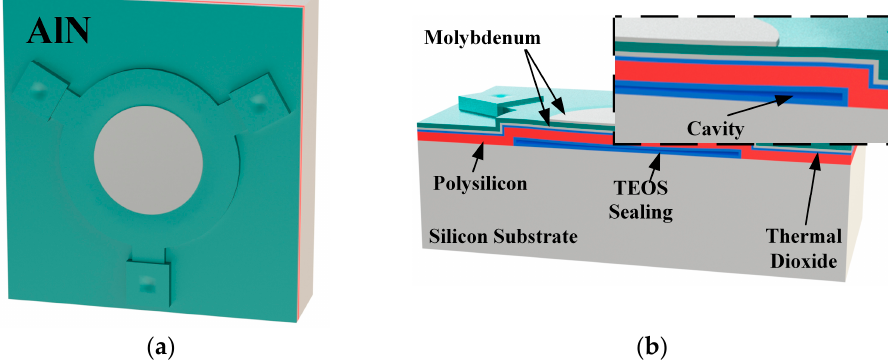
Figure 1. ( a ) The three-dimensional schematic of our PMUT unit. ( b ) The cross-section of a single PMUT unit and the enlarged view of the cavity structure.